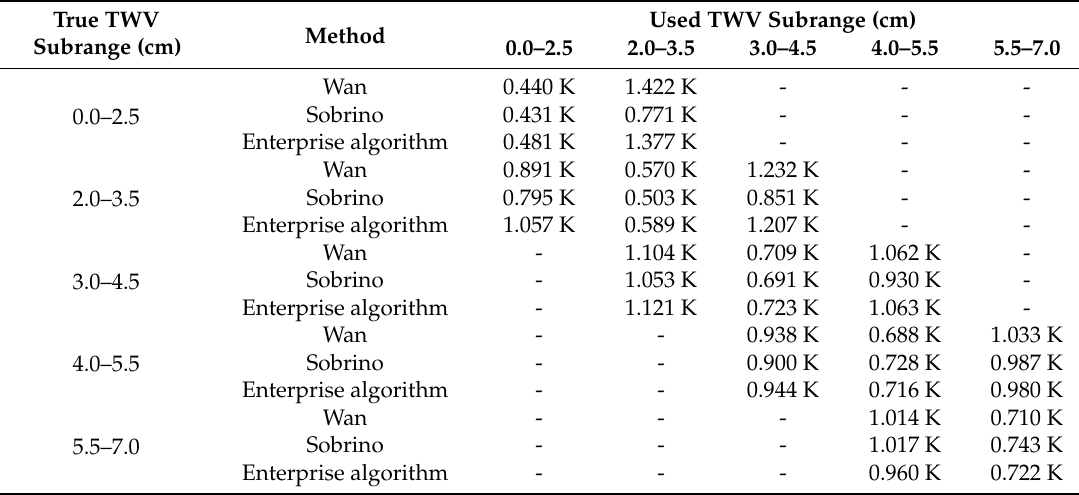
Table 4. RMSEs of LST retrieval due to incorrectly using of coefficients of the adjacent total water vapor content (TWV)